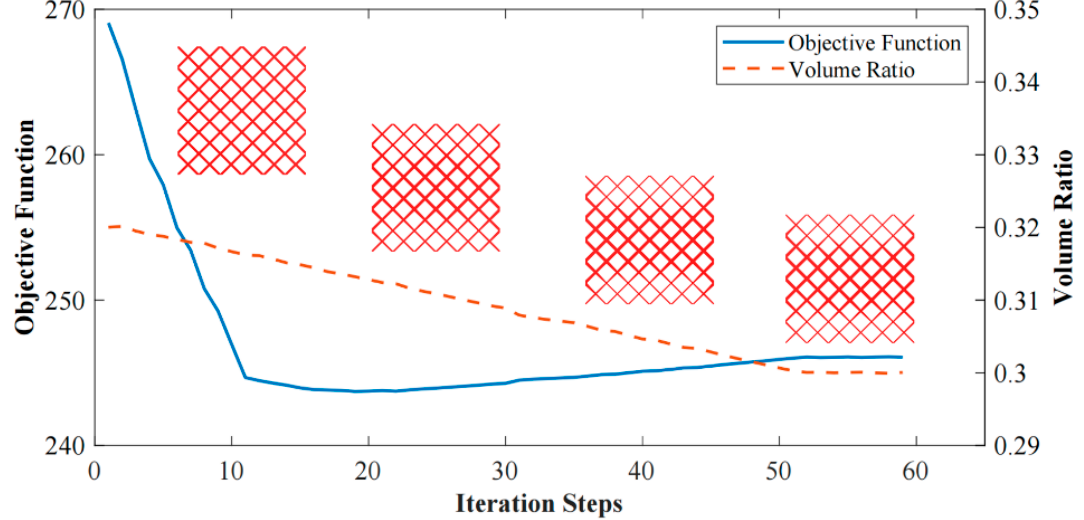
Figure 9. Interaction history of 3D TWSS design.